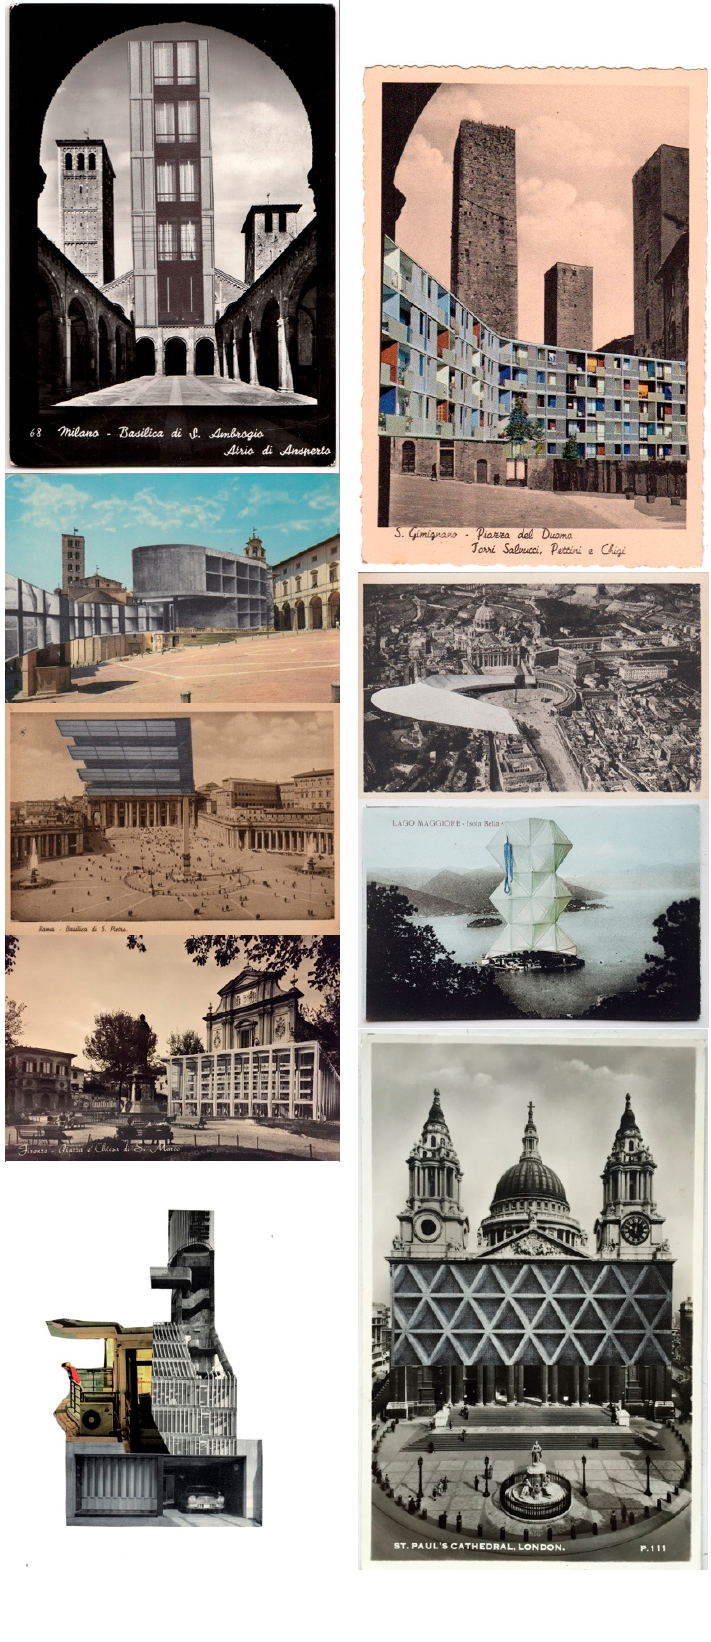
Figure 1. The series of collages describes the process of assimilating the images of my archive, in a new production of images. Those images create a new Atlas of design possibilities for the contemnporary